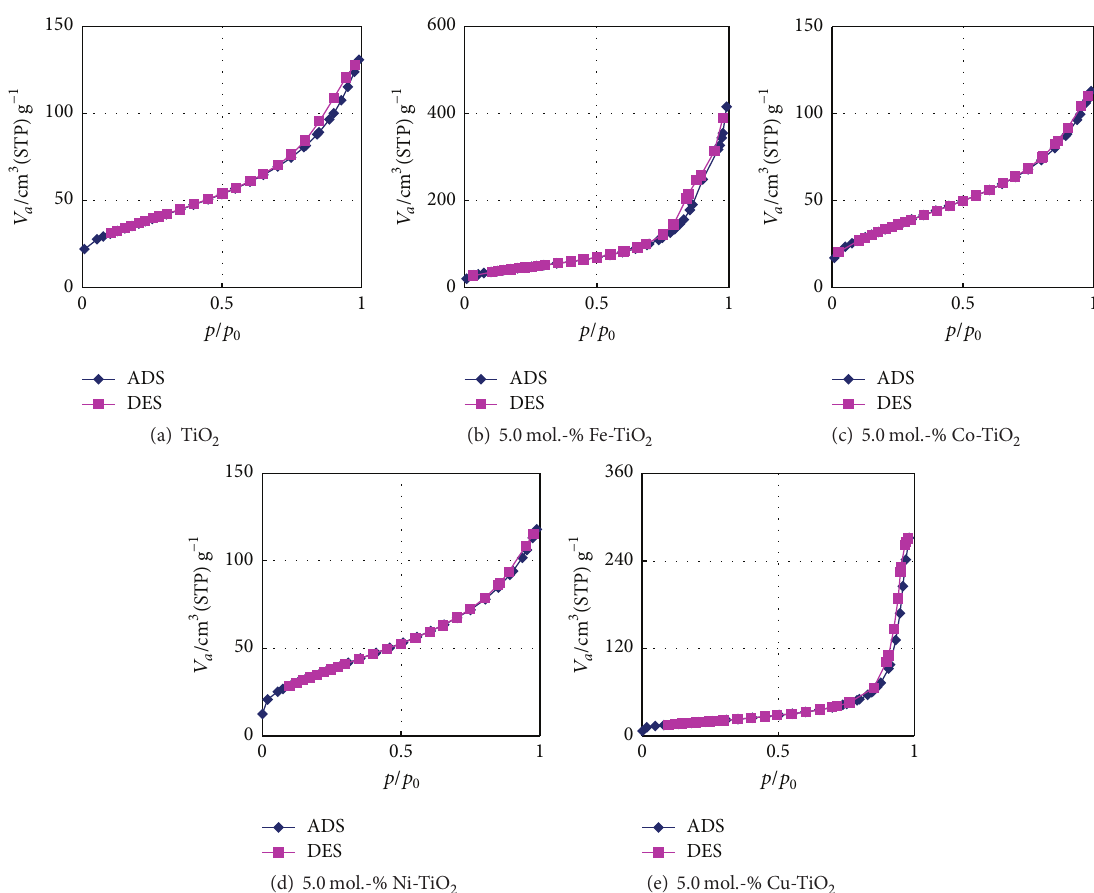
Figure 5: Adsorption-desorption isotherm curves of N 2 at 77 K for the as-synthesized 5.0 mol.% M-TiO 2 particles.